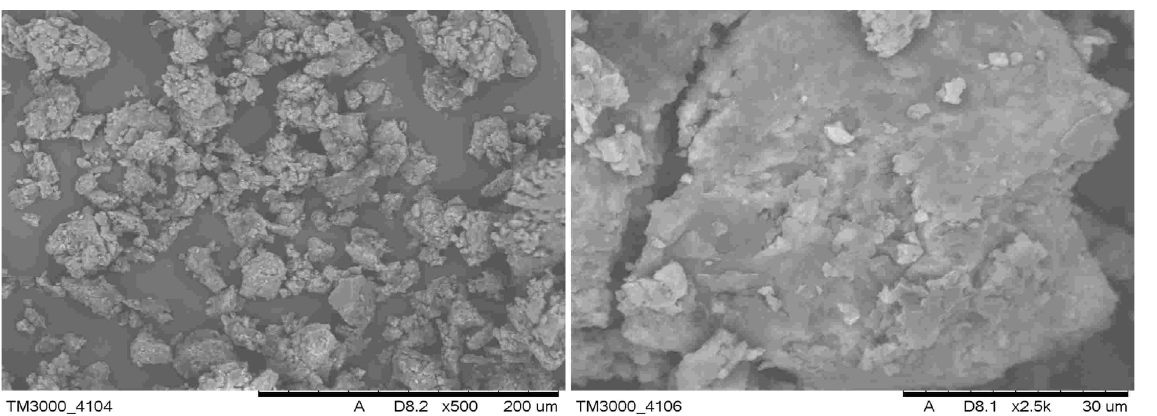
Figure 2: Sediment obtained after wastewater treatment with dose 6.0 mL PIX 113 per 1